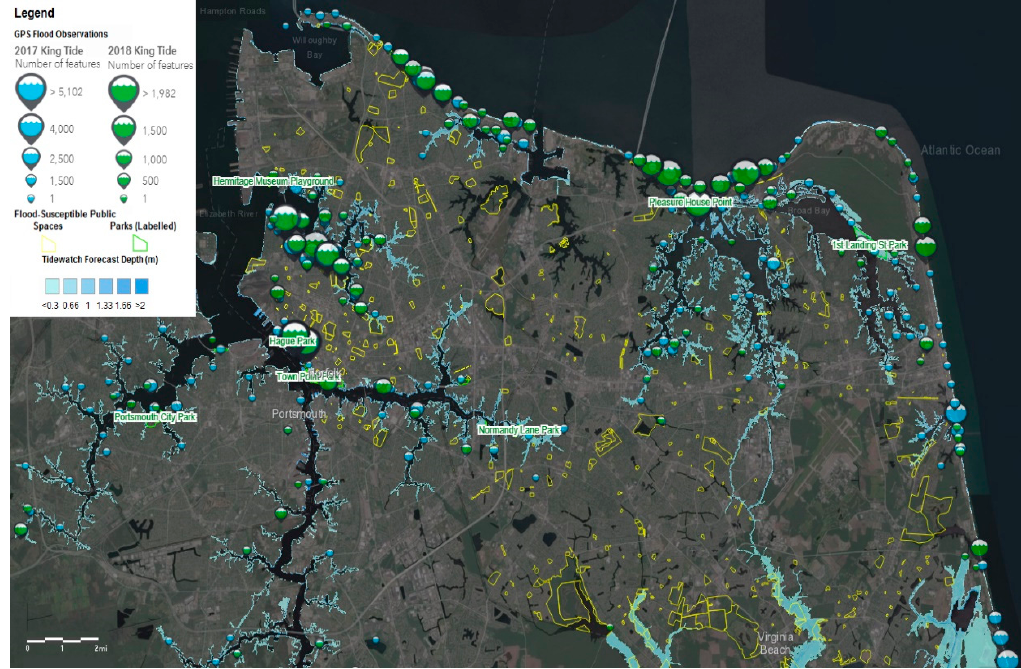
Figure 4. Comparison map of Catch the King citizen science king tide data collection between 2017 (blue dots) and 2018 (green dots); points are aggregated by density. Yellow polygons illustrate a public spaces inventory, where volunteers were encouraged to map, while green-labelled park polygons were places where official Catch the King volunteer training events occurred. There were 35